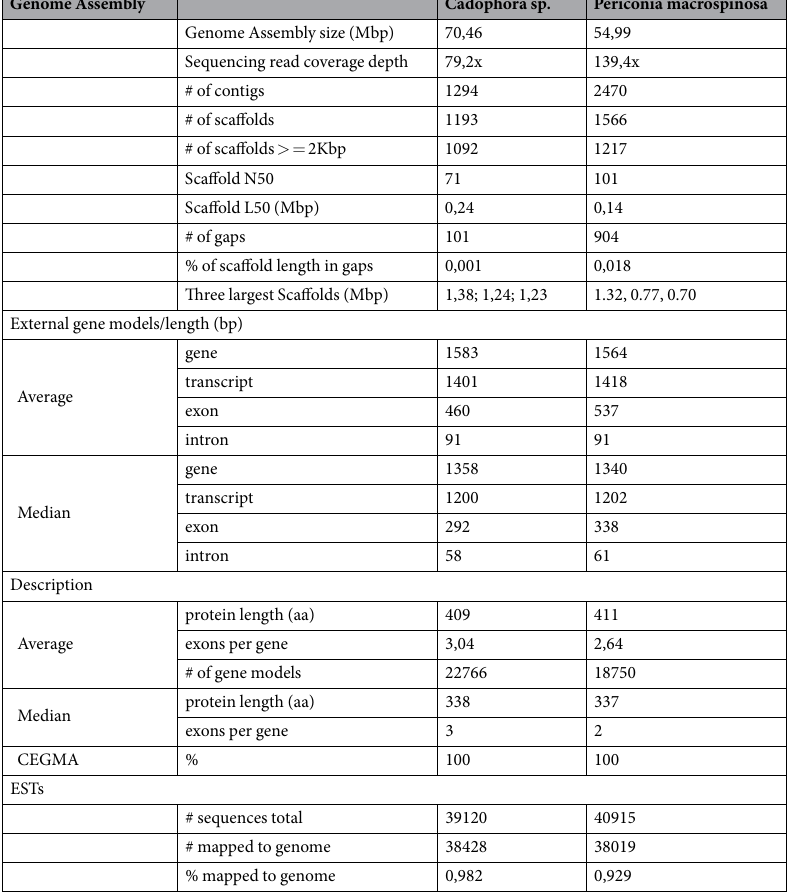
Table 1. Genome statistics of Cadophora sp. DSE1049 and Periconia macrospinosa